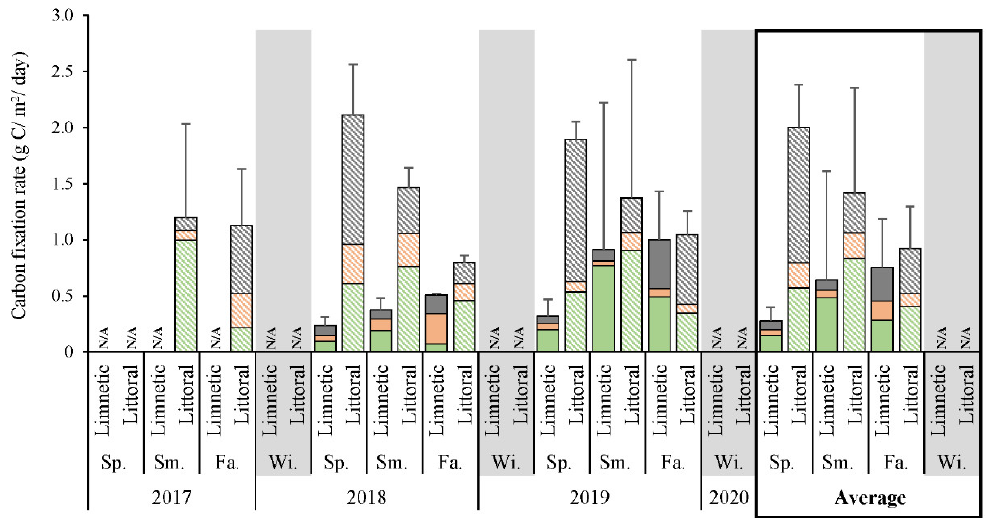
Figure 3. Primary productivity of Lake Winnipeg. 14 C fixation measured in situ with total rates com- posed of oxygenic (green) or anoxygenic (orange) photosynthesis related fixation, and from dark chemosynthetic reactions (grey bars). N/A, not analyzed; Sp., Spring; Sm., Summer; Fa., Fall; Wi., Winter.